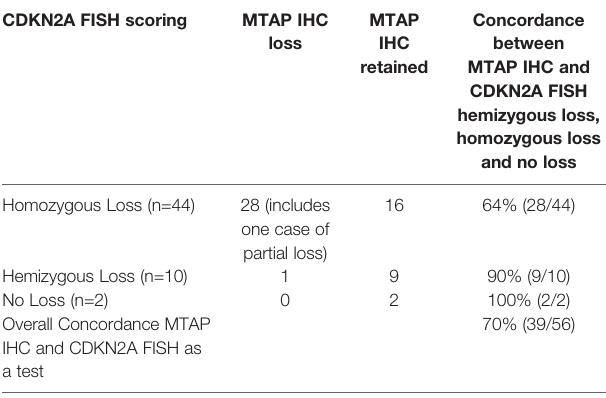
TABLE 9B | Comparison of methylthioadenosine phosphorylase (MTAP) immunohistochemistry (IHC) and CDKN2A fl uorescence in situ hybridization (FISH) homozygous and hemizygous deletion, and no loss (retention).